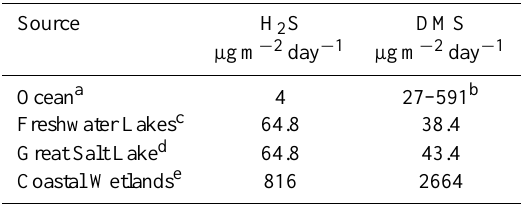
Table A1. Natural source reduced sulfur emissions factors.